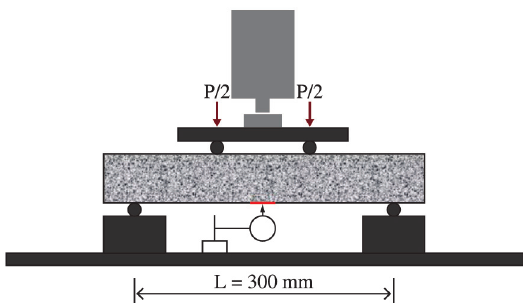
Figure 2. Schematic of the setup used for four point loading of the concrete Table 2. Mechanical properties for the concretes. Concrete